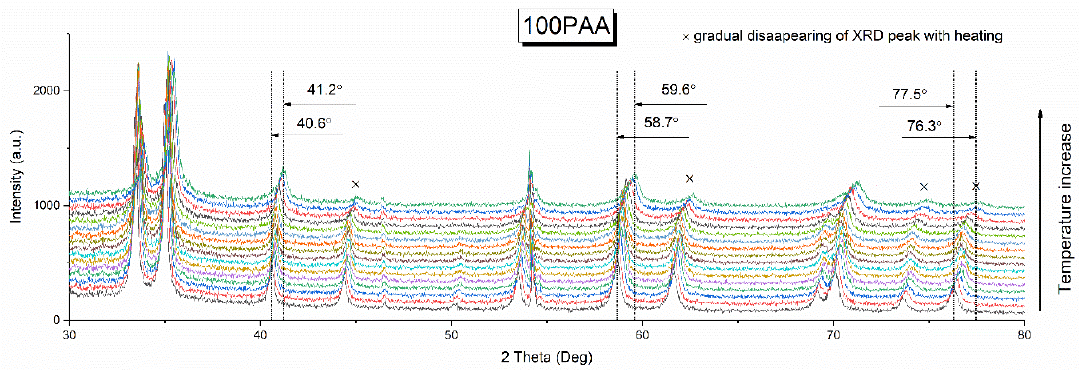
Figure 4. In situ X-ray patterns obtained for the 100PAA sample without the binder upon heating in the range 30–330 °C with steps of 10 °C.